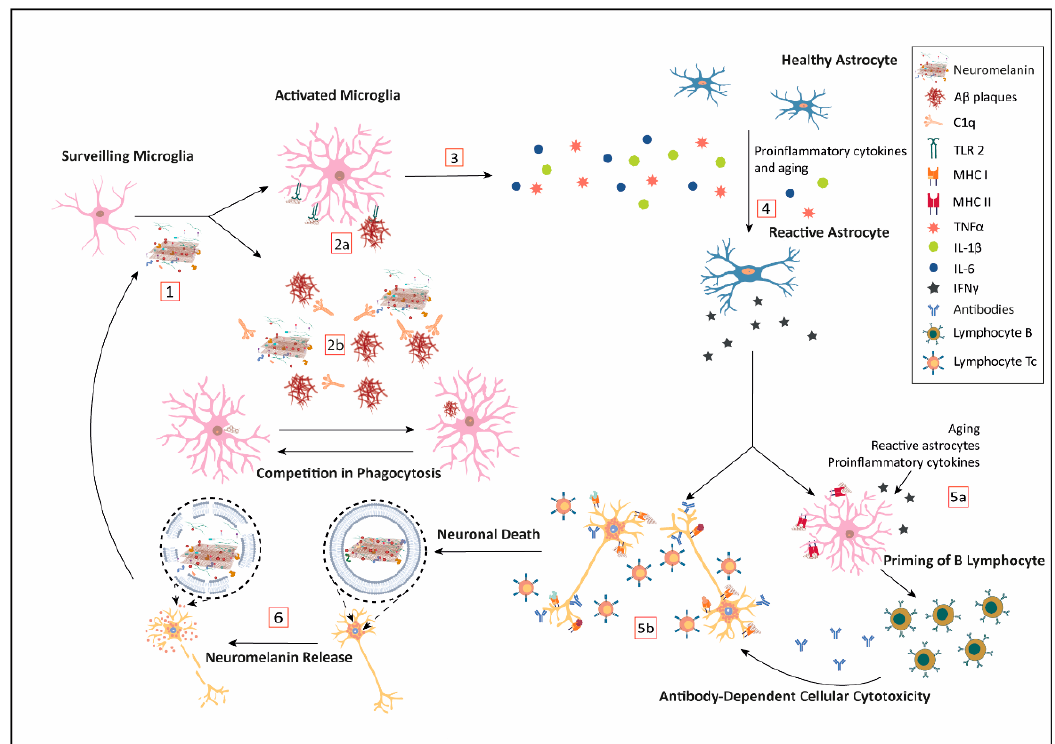
Figure 1. Immune response to the neuromelanin (NM) release to brain parenchyma. Upon neuronal cell death, surveilling microglia engulf cellular debris. The NM released to the brain parenchyma is less stable than the intracellular vesicle- contained NM, and therefore may distribute its toxic load throughout the tissue, triggering microglial activation (1). At the same time, NM may interact with the protein C1q which facilitates its phagocytosis, hindering, in turn, the clearance of amyloid deposits by competition (2b). Simultaneously, NM structure could interact with microglial toll-like receptor 2 (TLR2) (2a) promoting the secretion of pro-inflammatory interleukins (3). These secreted interleukins will amplify neuroinflammation, impairing other neurological structures, and transforming astroglial cells into reactive astrocytes that produce INF γ (4). Activated microglia by INF γ stimulus will express major histocompatibility complex (MHC) class I, displaying portions of NM and its load that in the deep cervical lymph nodes could prime B cells, potentially inducing an autoimmune response (5a). Parallelly, INF γ also induces the expression of MHC class I in healthy neurons, and similar to MHC class II in microglia, MHC class I can present modified antigens through its binding to NM, thus triggering Tc lymphocytes attack (5b). Finally, increased cell death is associated with a higher release of NM, establishing a feedback loop that exacerbates a pathological immune response (6).